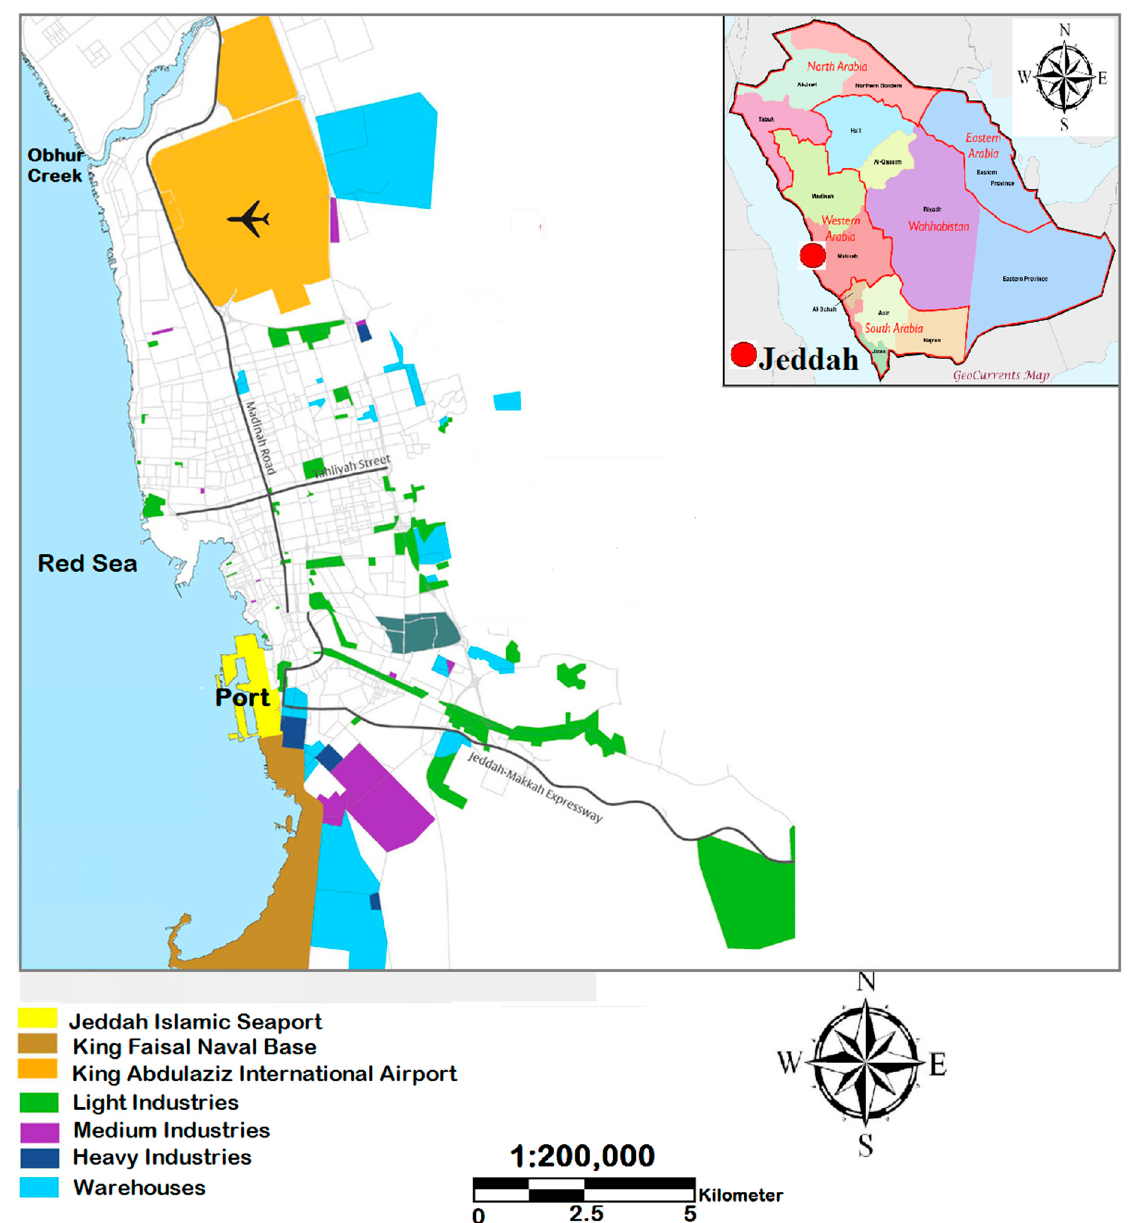
Figure 1. Map of Jeddah city showing sensitive land use facilities (Source: Author, 2019). Table 1. The survey respondents by expertise.